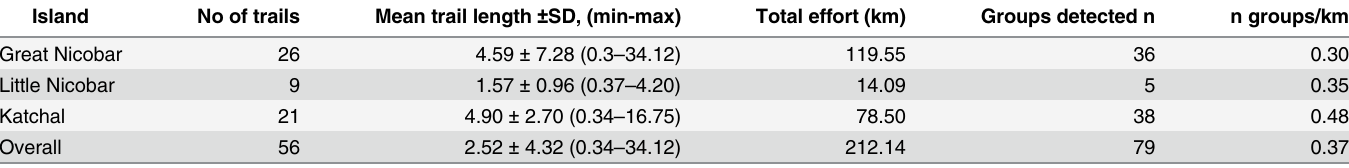
Table 1. Mean number of M . f . umbrosus groups encountered per kilometre in Nicobar Islands.